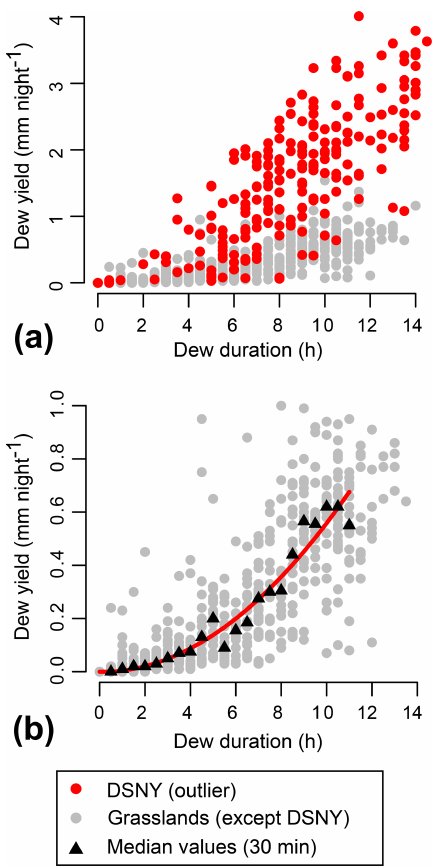
Figure 5. Dew yield versus dew duration for the grasslands (top of the canopy, nightly timescale). (a) shows the failure of the Monin– Obukhov Similarity Theory for DSNY, which is why the quadratic fit ( y = a × x 2 ,a = 0 . 0056mmh − 2 ,r 2 = 0 . 94) has been calculated for the other grasslands based on the 30min median values for dew durations between 1 and 11h (b)